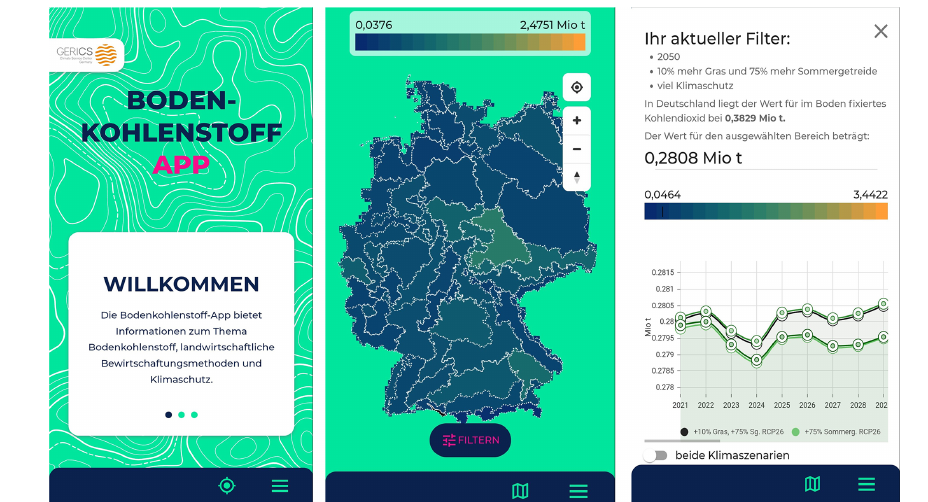
Figure 3. Three views from the application in its current state (from left to right: landing page, map of carbon variable covering Germany, time series displayed for one grid box). Source: Screenshots of developer view – current work status in application